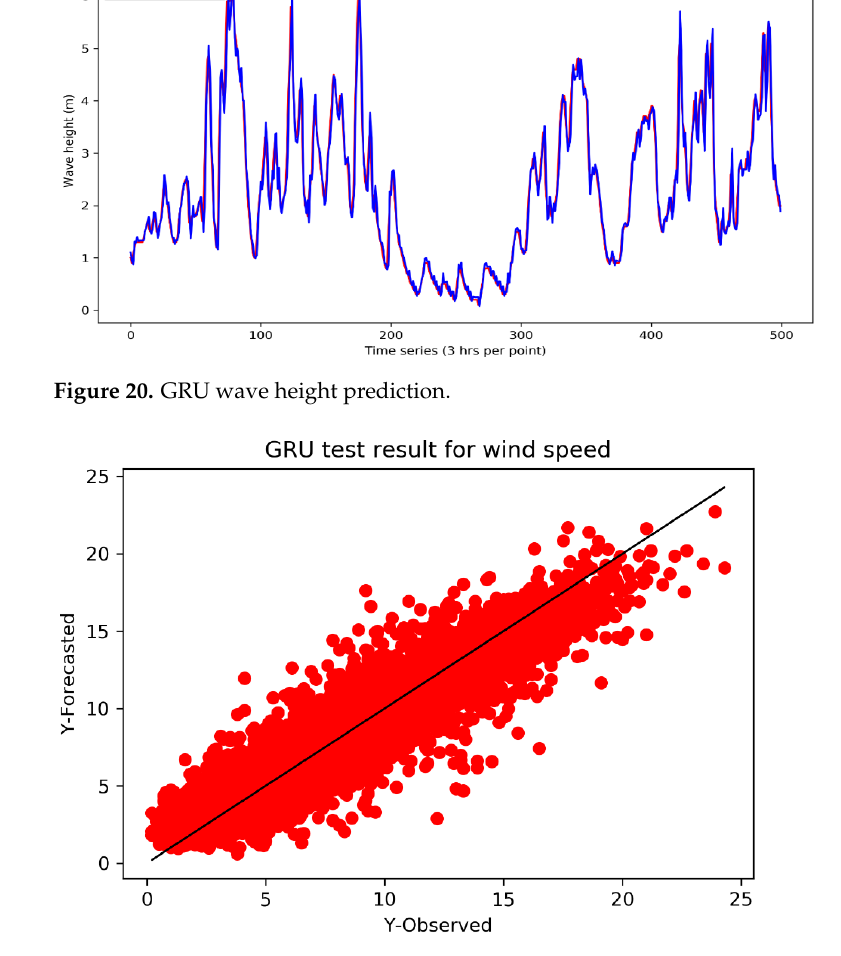
Figure 21. GRU-based wind speed models error analysis.